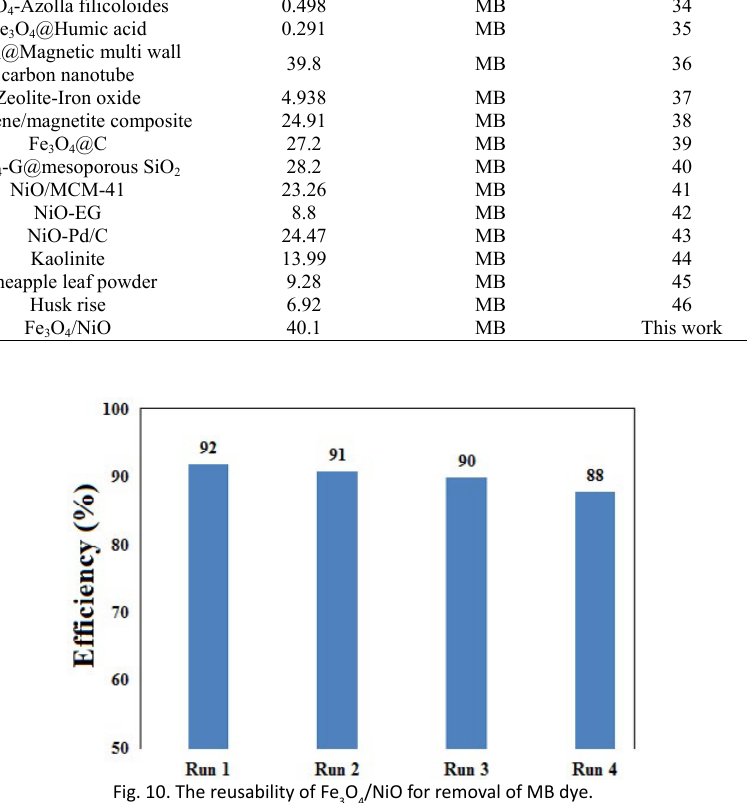
Fig. 10. The reusability of Fe